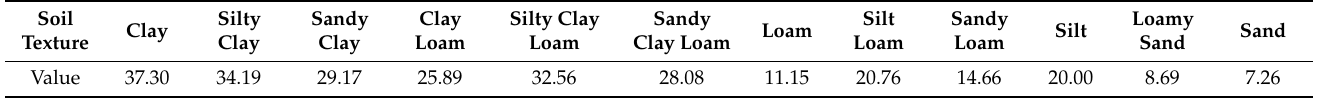
Table 1. Empirical values of the air-entry values for all soil